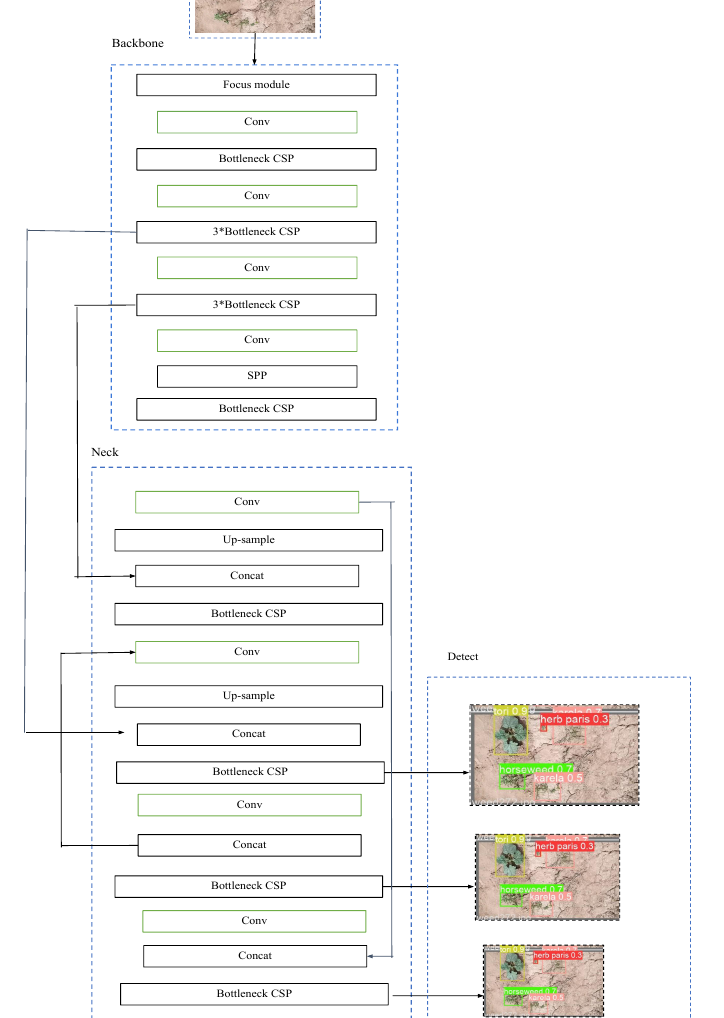
Figure 6. Architecture of the single-shot YOLOv5s model showing its three main components, i.e., the backbone network, neck network, and detect